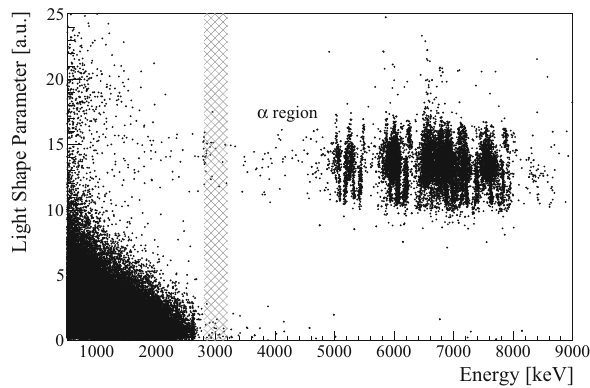
Fig. 8 Light Shape Parameter (SP) as a function of the heat released in the ZnSe (all crystals). The dashed region identifies the 400keV region centered around the 82 Se Q-value that is used for the 0 ν DBD analysis and for the estimation of the background